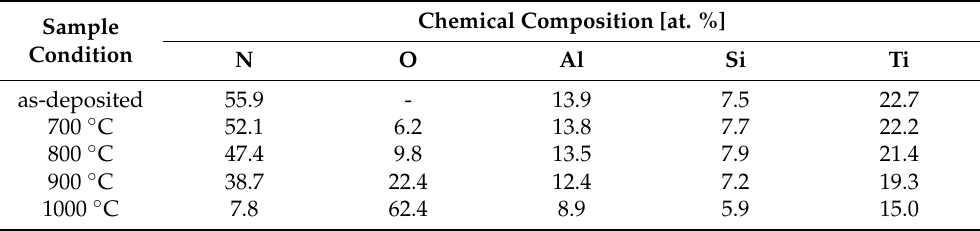
Table 3. Chemical composition of AlTiSiN/TiSiN coatings measured by EDX in the cross-sections. Chemical Composition [at. %] Sample Condition N O